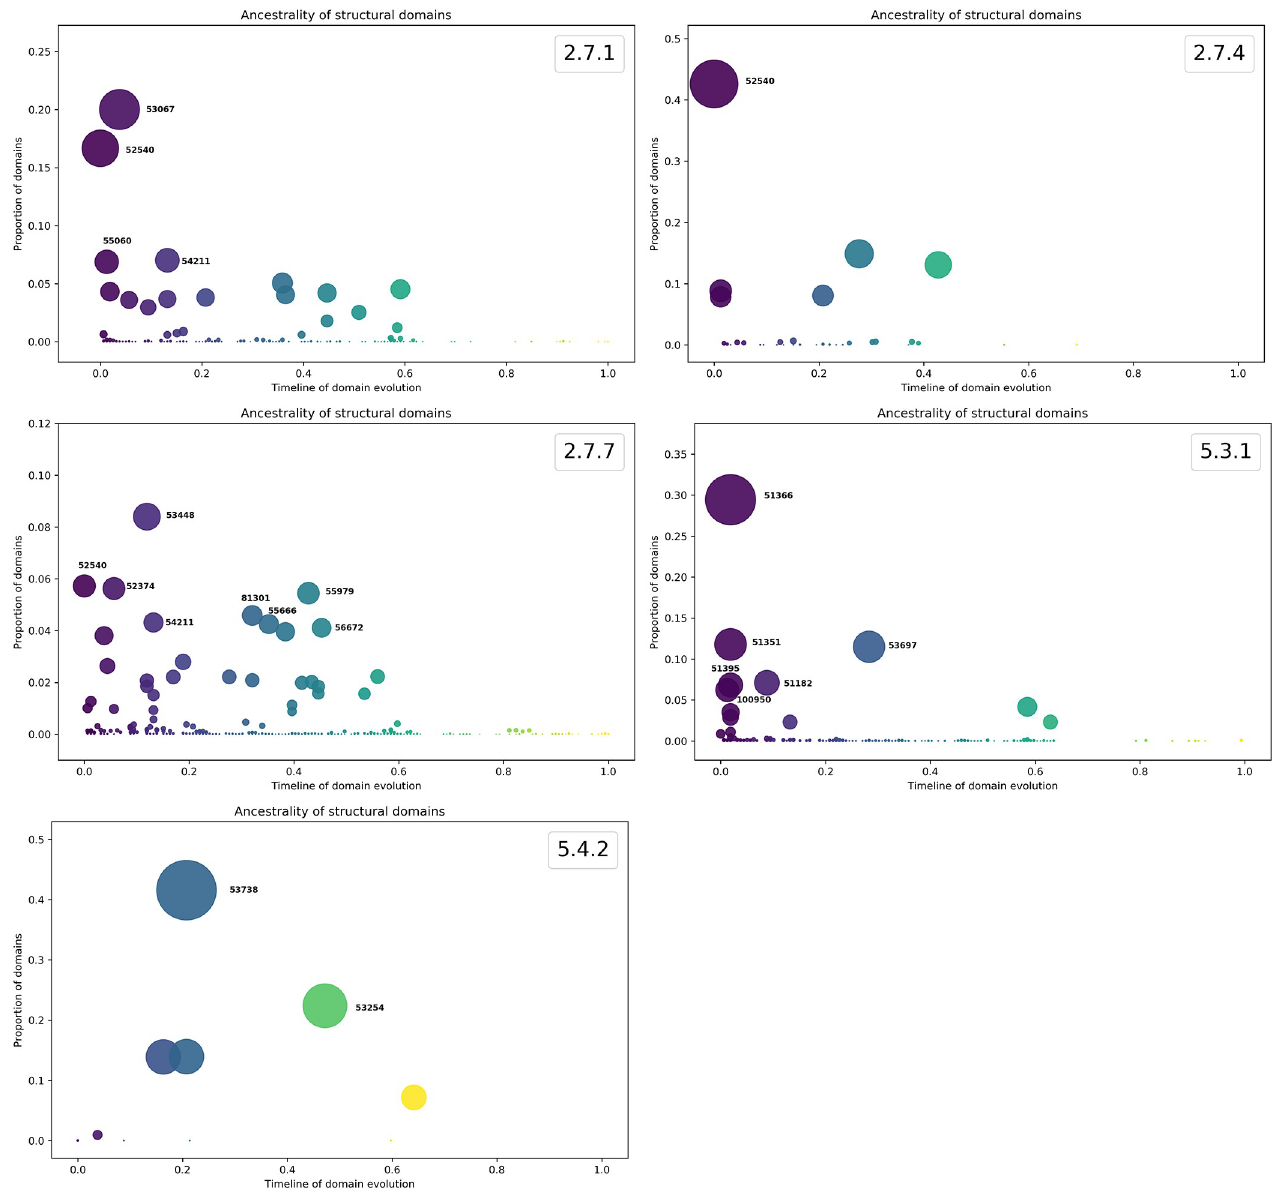
Fig 3. Ancestrality and abundance of the structural domains of universal enzymatic reactions: a) 2.7.1, b) 2.7.4, c) 2.7.7, d) 5.3.1 and e) 5.4.2. The timeline assigns how ancient each structural domain present in the universal enzymatic reactions is, as suggested by Caetano-Anolle´s et al [19].